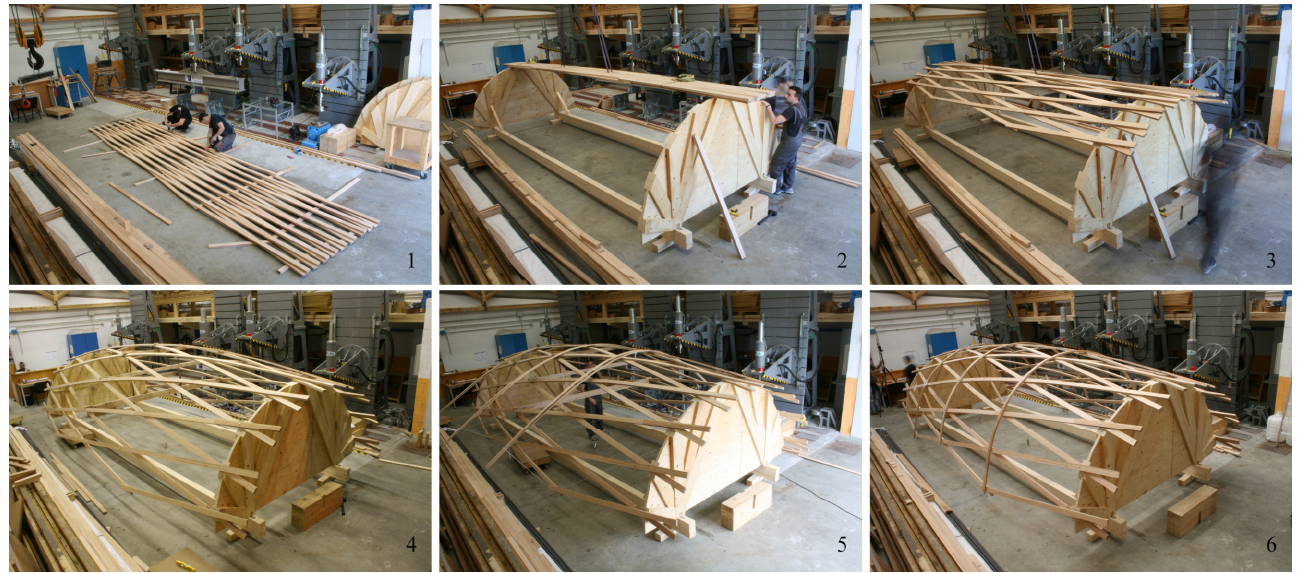
Figure 3. Construction process of the TEL-gridshell lab prototype.